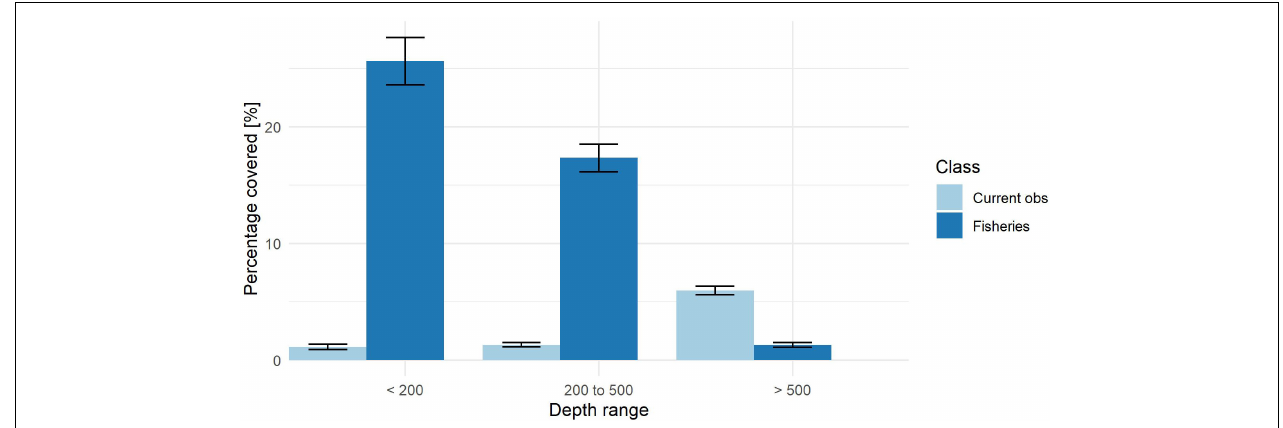
FIGURE 10 | The Global Ocean monthly mean global sub-surface observation and fishing coverage per depth category. TABLE 4 | Summary statistics comparing observation and fisheries coverage for the global ocean.